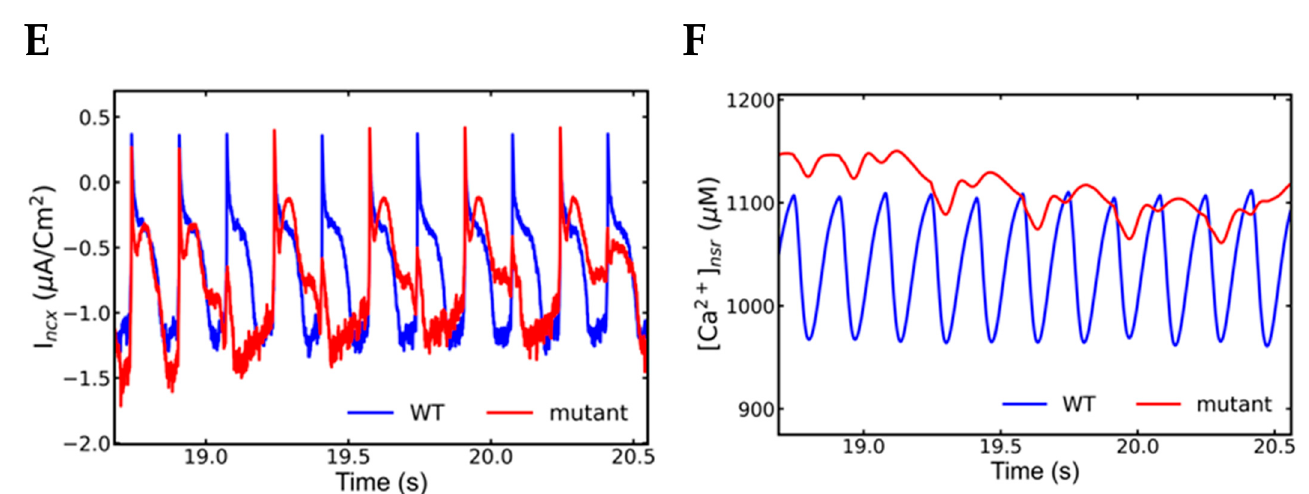
Figure 12. Simulation of action potential and other ionic currents in 6 Hz pacing of a mutant myocyte with β -adrenergic stimulation displayed alternately beat missing (wild-type—blue, mutant—red). The alternation in the beats happens due to the inactivation of Na + channels. ( A ) Inactivation of Na + channels is responsible for alternate action potential with alternately missing beats. ( B ) L–type (I Ca ) channels are also alternately activated because they need Na + current, I Na ( C ) to increase membrane voltage to activate them. Na + channels inactivate themselves in the peak action potential by closing their inactivation gates ( D ). Rapidly paced myocyte has a higher level of intracellular Ca 2+ and the late resurgence of Na + occurs by removing excess Ca 2+ by I ncx ( E ) and prevents Na + channels to recover from the previous inactivation. When SR Ca 2+ level diminishes ( F ), then myocyte gets back to regular beating. The simulation was repeated 10 times with different seeds for the pseudo random number generator and the patterns observed were repeated each time. Shown here is a representative simulation.